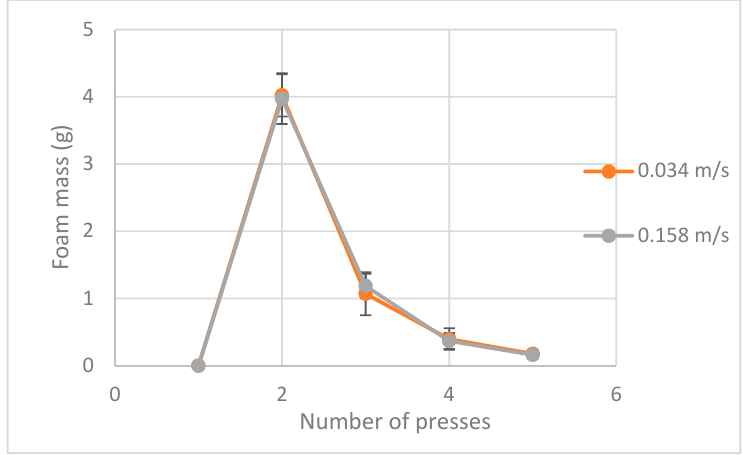
Figure 7. Foam mass for each compression of a dishwasher sponge saturated with 20% commercial dishwashing solution with different compression rates.